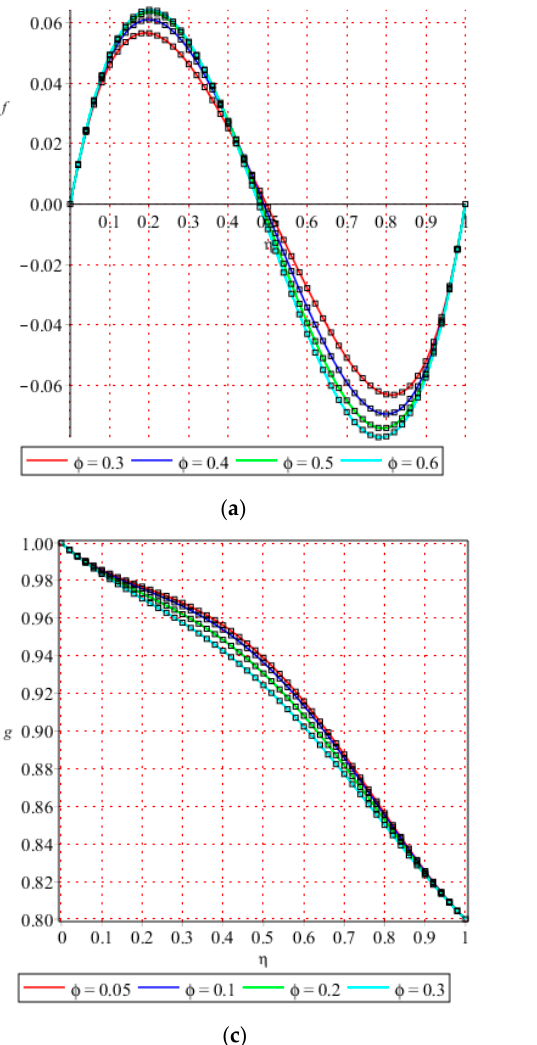
Figure 3. Influence of Re on ( a , b ). Temperature 𝜃(cid:4666)𝜂(cid:4667) . ( a ) SWCNTs , ( b ) MWCNTs .